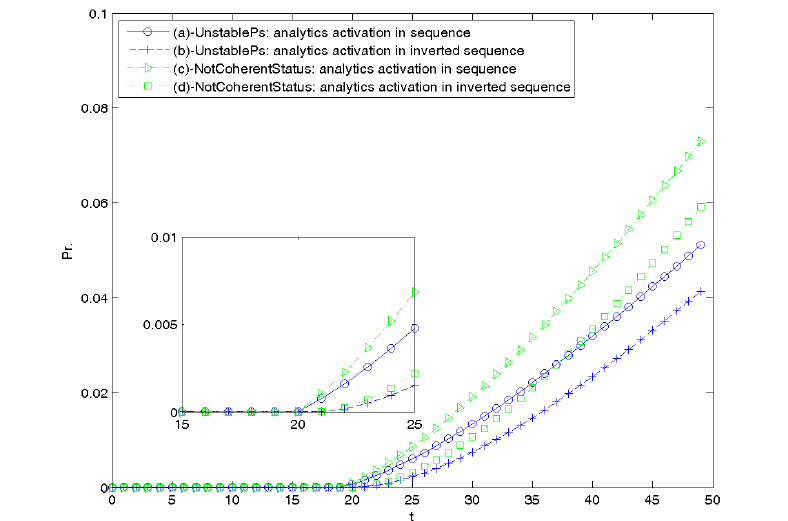
Figure 9. Task: monitoring. Analytics raising alerts in the order compatible with the attack path or in reverse